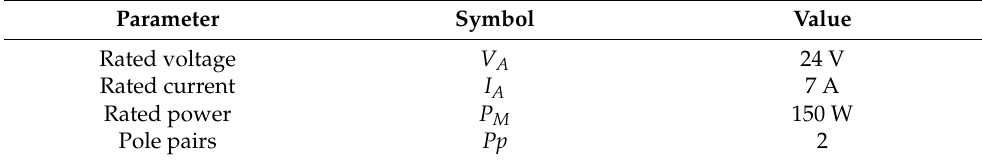
Figure 2. ( a ) Block diagram of the measuring system; ( b ) laboratory setup. Table 2. BLDC motor